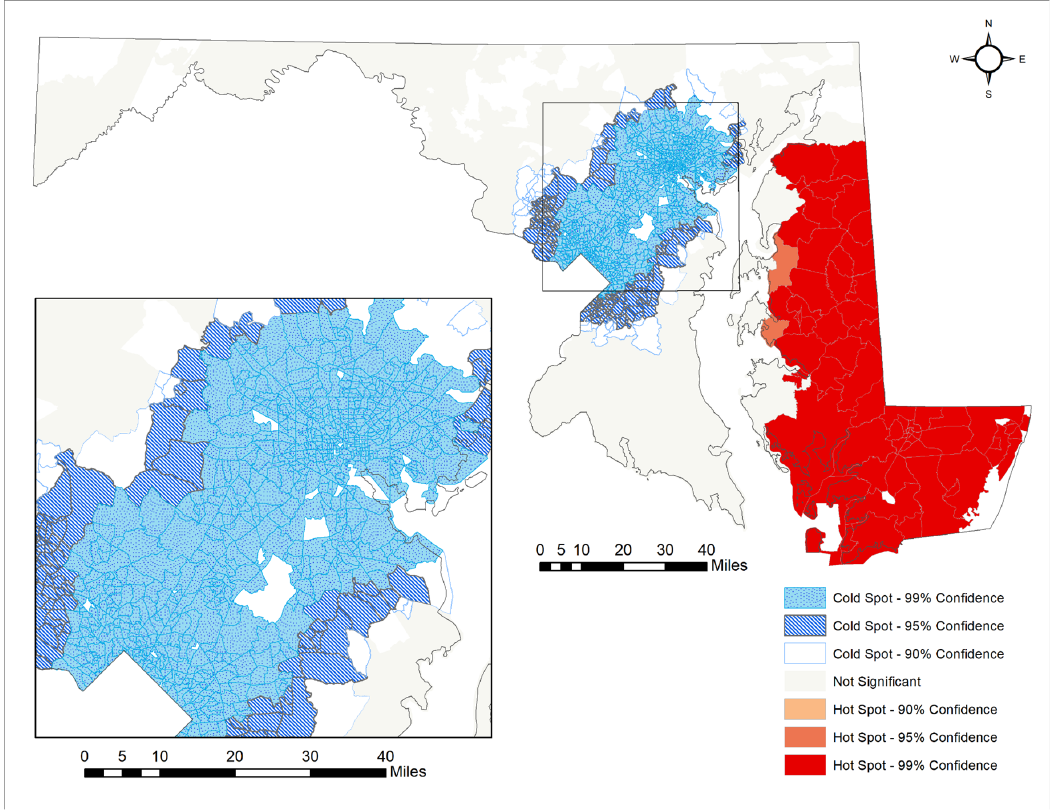
Figure 2. Optimized Hot Spot Analysis for Chicken CAFOs in Maryland.